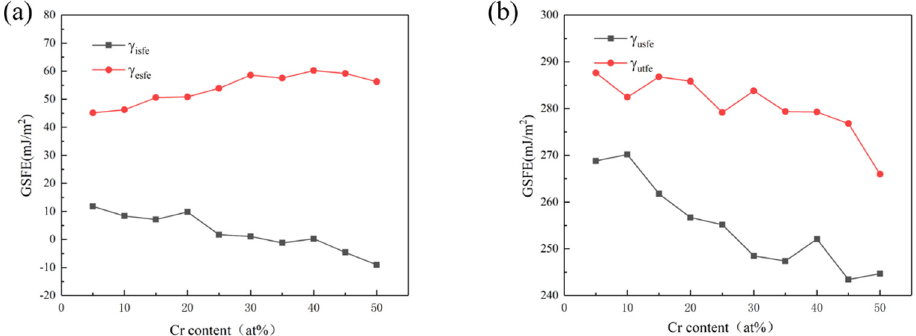
Figure 2. Curves of the γ isfe , γ esfe ( a ), and γ usfe , γ utfe ( b ) as the content of Cr element is varied.